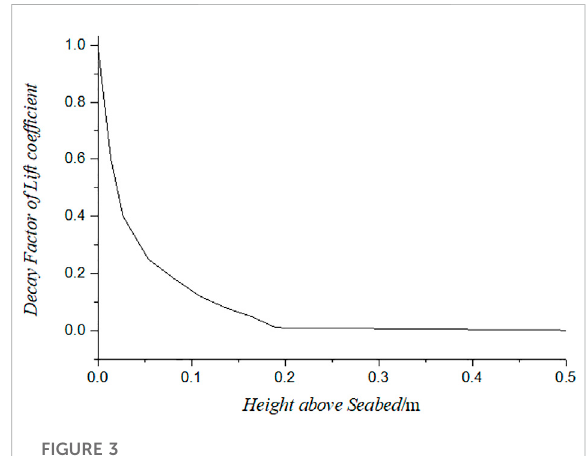
FIGURE 3 Lift coef fi cient of the pipeline versus height above